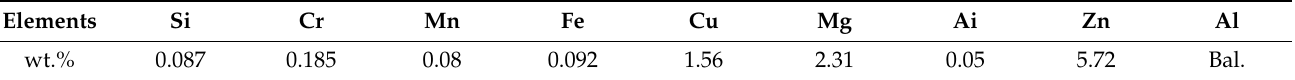
Table 2. Al7075 alloy